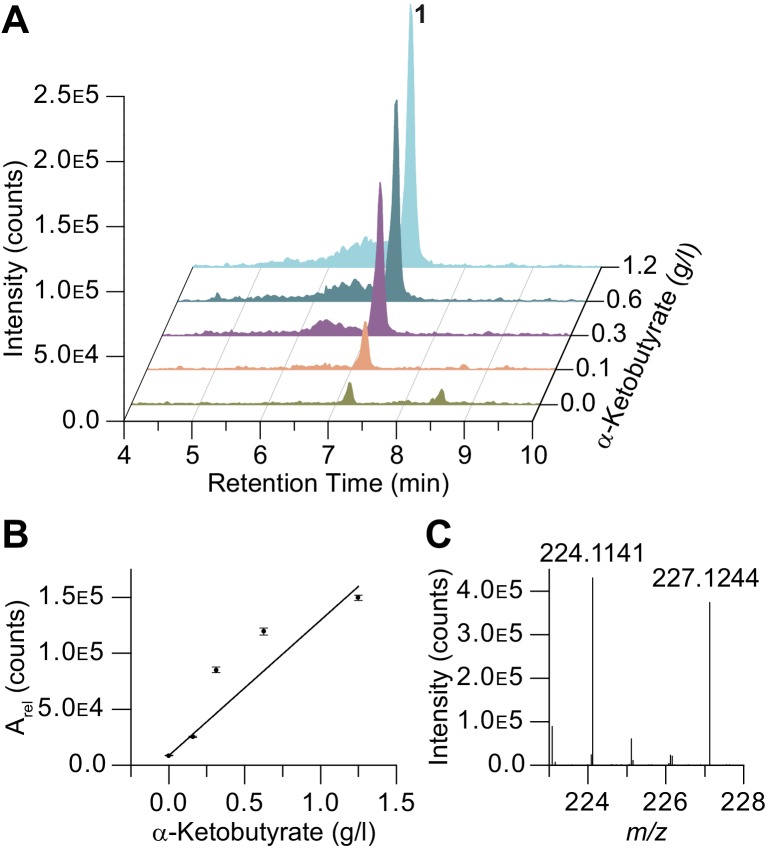
α-Ketobutyrate feeding studies on 1.(A–B) Production enhancement of 1 in α-ketobutyrate supplementation studies (Arel, relative integration value). (C) 13C4-α-ketobutyrate supplementation leads to 13C3 incorporation in 1 consistent with the proposed biosynthesis.